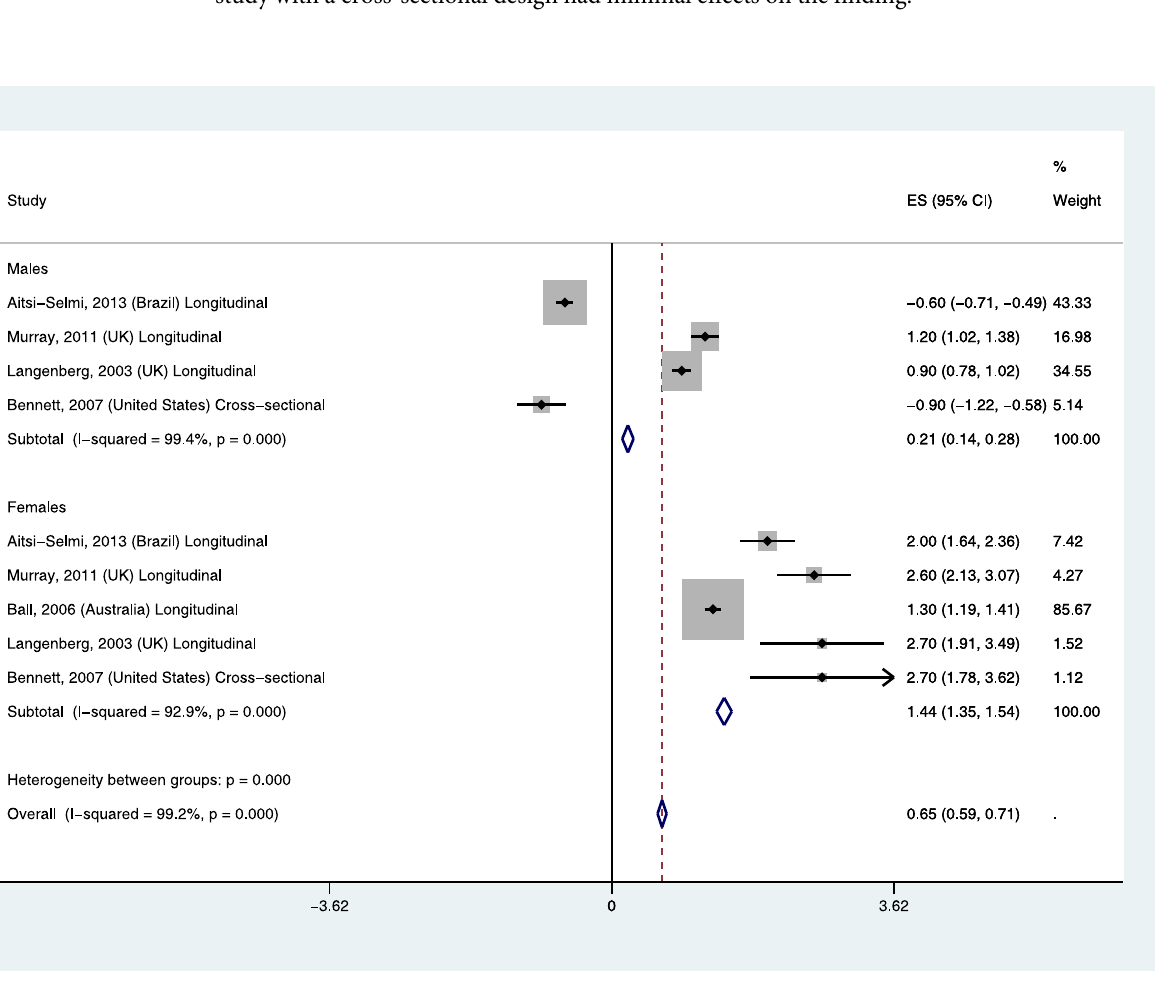
Fig 2. Mean BMI difference by life course SES.